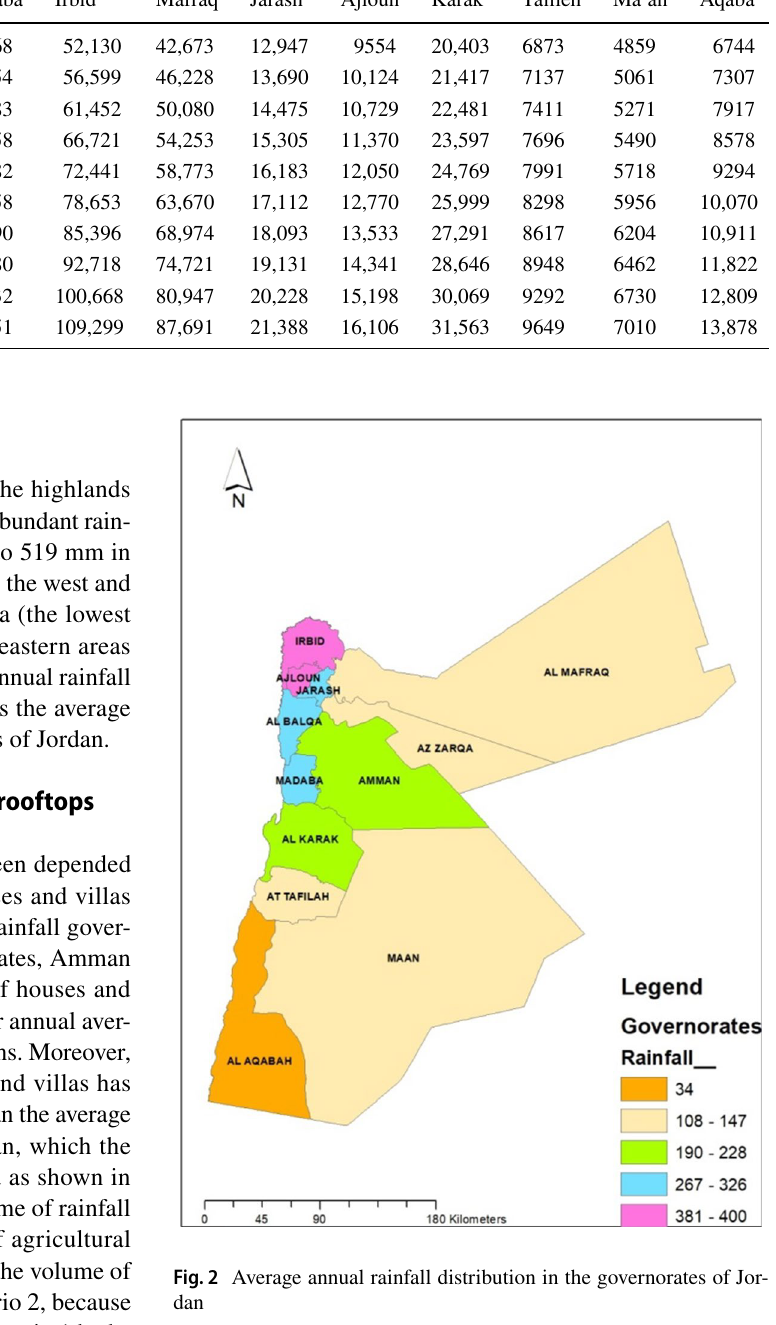
where the apartments were included in its study.